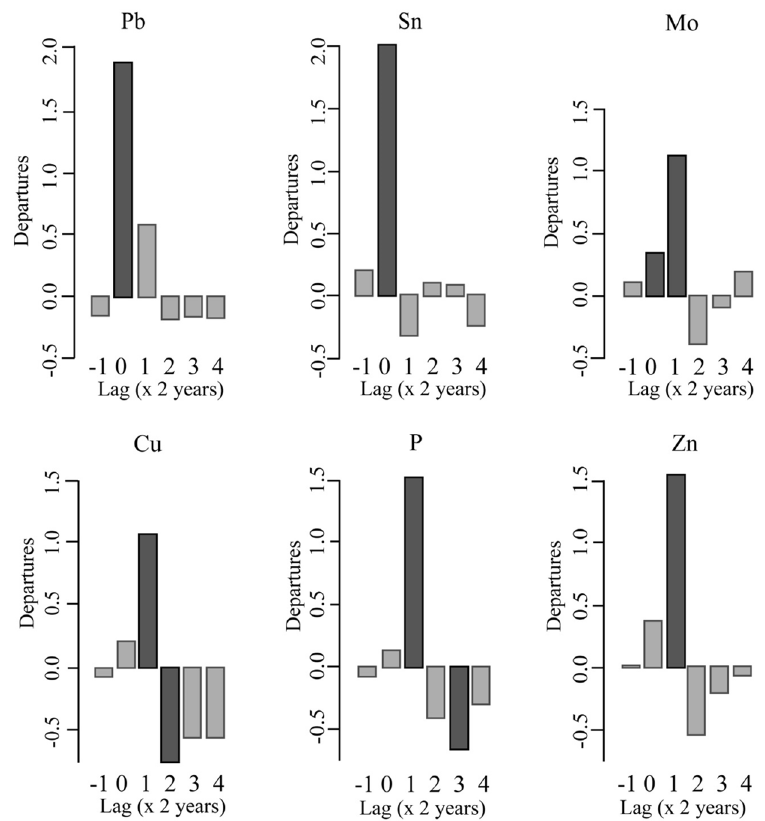
Figure 5. Superposed epoch analysis (SEA) comparing the normalized departures (z-scores) of chemical tracers of past eruptions (TPE: Pb, Sn, Mo, Cu, P, and Zn) contained in biennium portions of F. cupressoides tree rings corresponding to the Calbuco eruptions with a VEI ≥ 3 for the period 1850–2016 AD. The X -axis represents a set of 6 biennia equivalent to 12 years, from 2 years before the eruption to 9 years following it. Black bars represent significant confidence levels at 95% after 1000 Monte Carlo iterations.